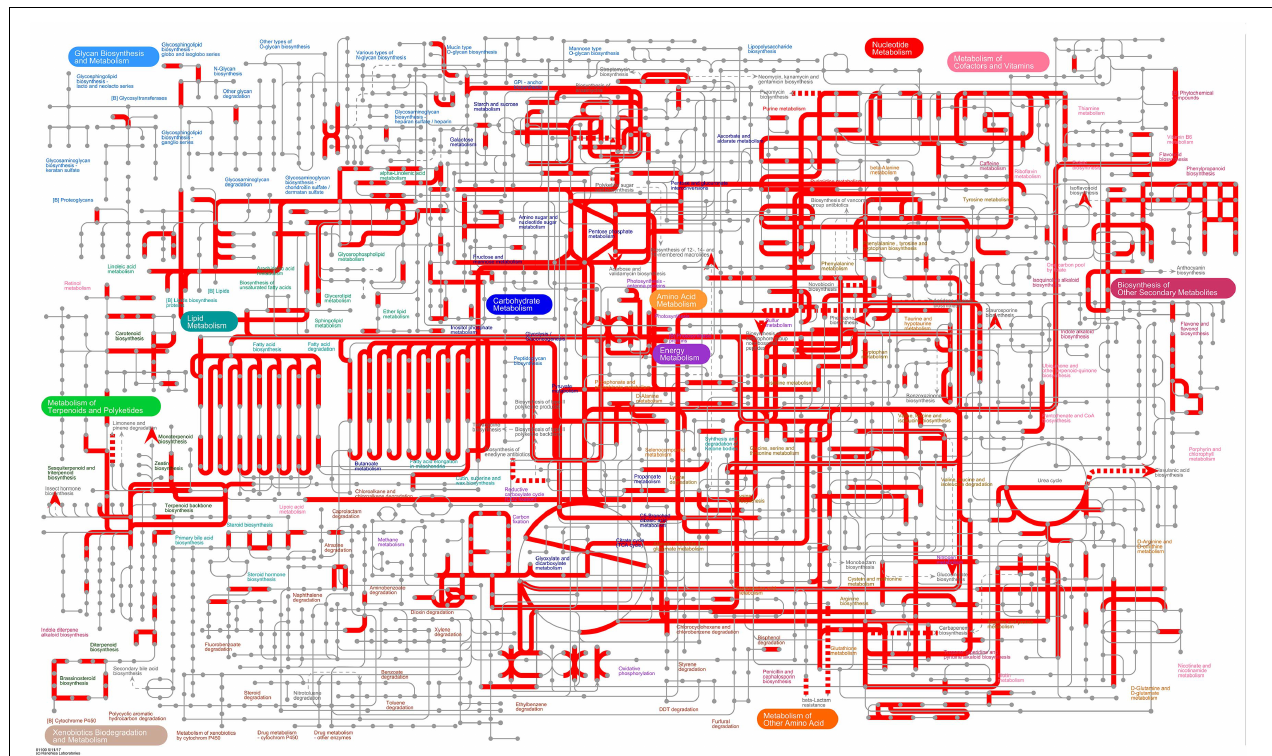
FIGURE 7 | Overview of the metabolic pathways of DEGs between healthy tomato plants (H) and tomato plants under different treatments (V, VQ, and HQ). The red lines represent pathways annotated by DEGs. H, healthy tomato plants. HQ, tomato plants was fed on by healthy B. tabaci for 24 h. V, tomato plants was inoculated with ToCV. VQ, tomato plants with ToCV that were fed on by healthy B. tabaci for 24